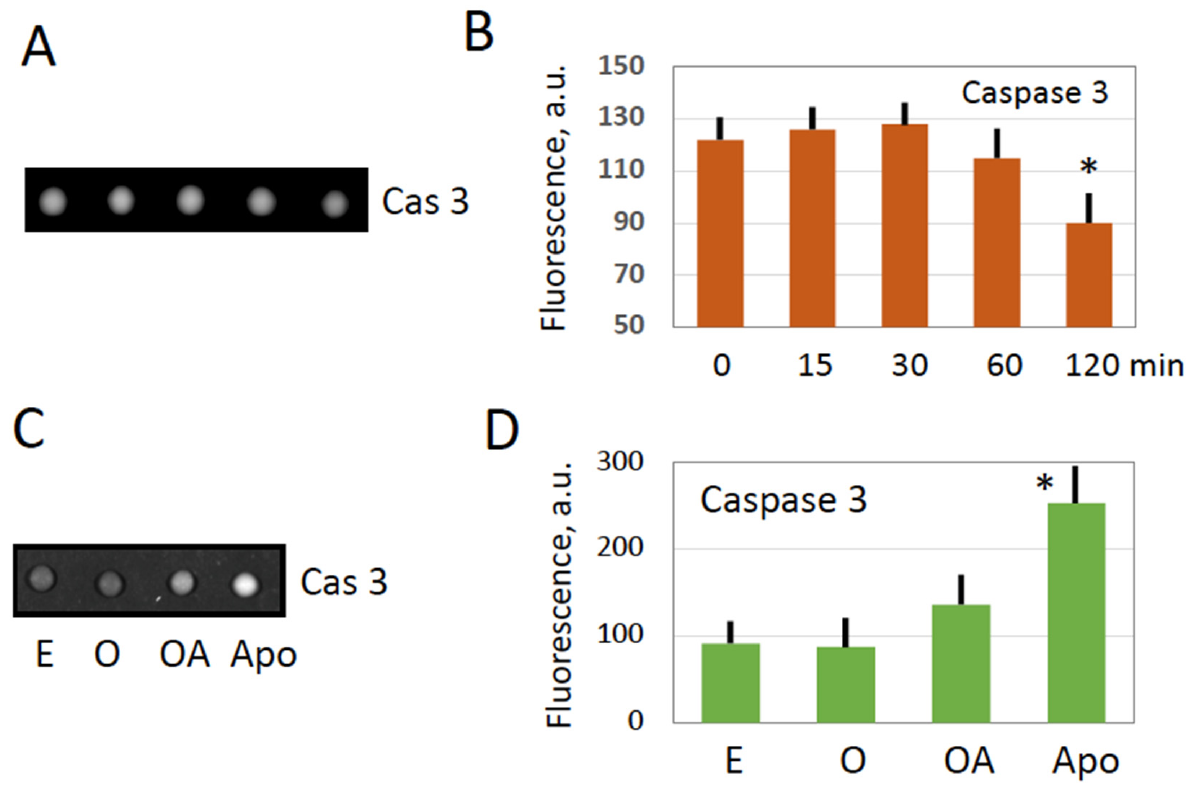
Figure 3. Caspase activity in overactivated frog eggs. Caspase 3/7 activity in the overactivated Xenopus eggs incubated with hydrogen peroxide for different times is presented in panels ( A , B ). Caspase activity in metaphase II-arrested (E), overactivated (OA), apoptotic (Apo) eggs, and oocytes (O) is presented in panels ( C , D ). Spot assays of caspase activity are shown in panels ( A , C ) and their quantification is presented in panels ( B , D ). In panels ( C , D ), overactivated eggs were collected after 1 h peroxide treatment, whereas apoptotic eggs were analyzed within 24–30 h of ovulation. The experiment was repeated with three separate batches of eggs obtained from different animals and the result of a single-batch experiment is shown. Bars in panels ( B , D ) represent SD values of the mean obtained in four measurements of the same experiment. Asterisks in the panels indicate statistical difference ( p < 0.05) from untreated control eggs (E).